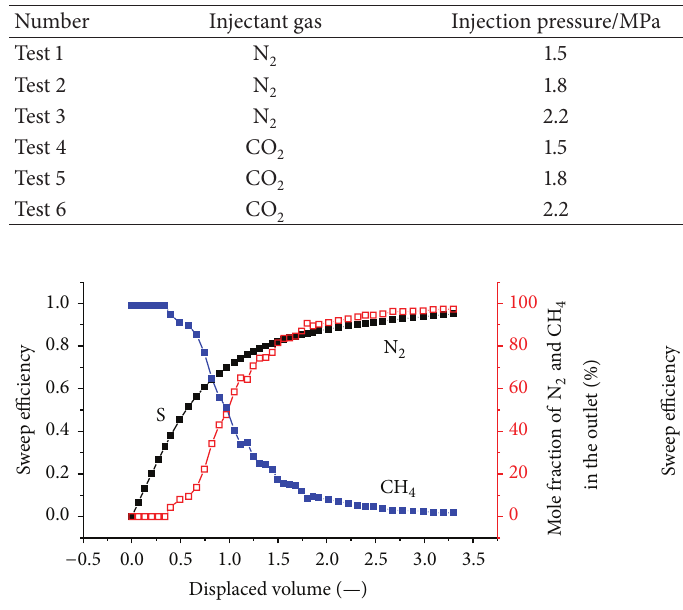
Table 2: Displacement experiment conditions and the results of different pressures of gas injection.